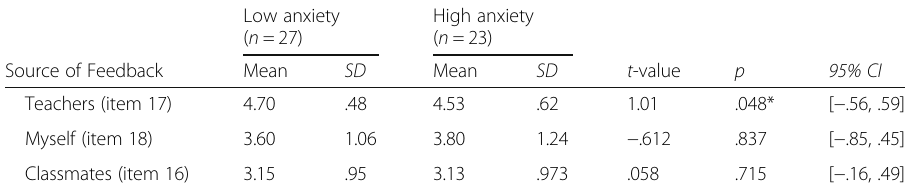
Table 3 Low/high Anxiety group responses to Source of